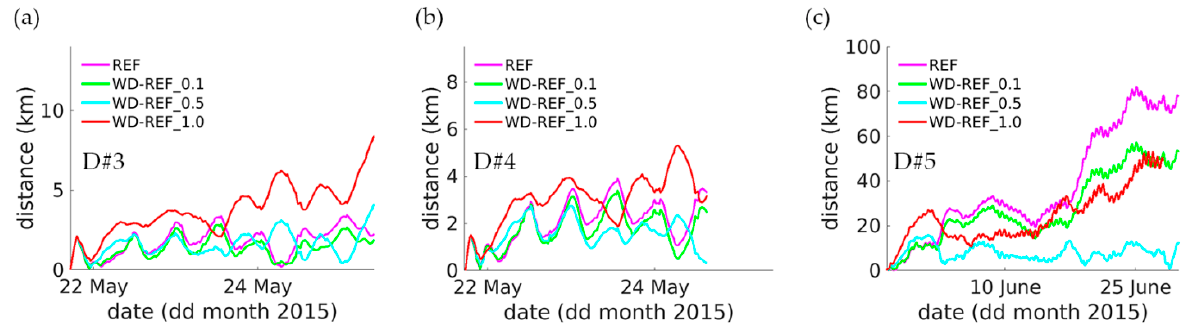
Figure 8. Time series of the separation distance (m) between the observed and model drifter #3 ( a ), #4 ( b ) and #5 ( c ) trajectories of WD-REF experiments with wind drag contributions of 0.1, 0.5 and 1.0%.